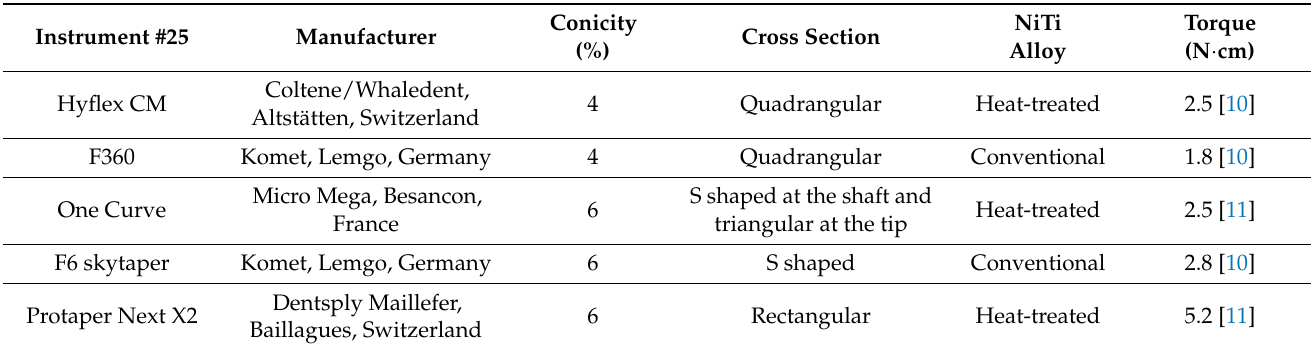
Table 1. Technical features (manufacturer, conicity and NiTi alloy) of analyzed instruments and maximum torque recom- mended by manufacturers (N.cm).